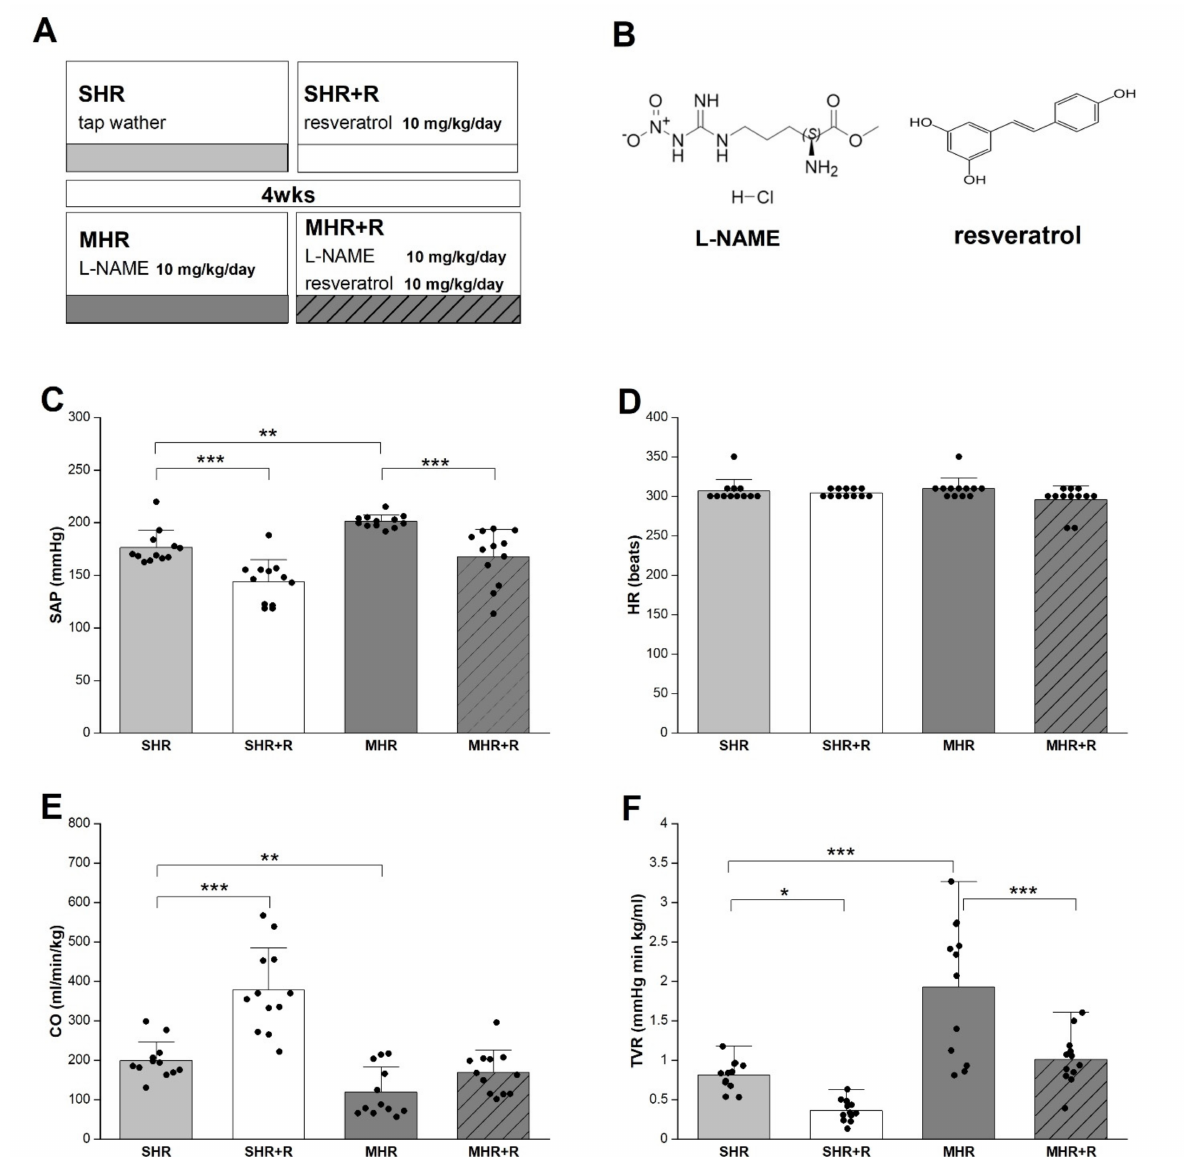
Figure 1. Graphical experimental layout ( A ), chemical formulas ( B ), systolic arterial pressure-SAP ( C ), heart rate-HR ( D ), cardiac output-CO ( E ) and total vascular resistance-TVR ( F ) in experimental groups. SHR-spontaneously hypertensive rat; SHR + R-spontaneously hypertensive rat treated with resveratrol; MHR-malignant hypertensive rat; MHR + R-malignant hypertensive rat treated with resveratrol. Values are means ± SD. ***, **, * indicate p < 0.001, 0.01,